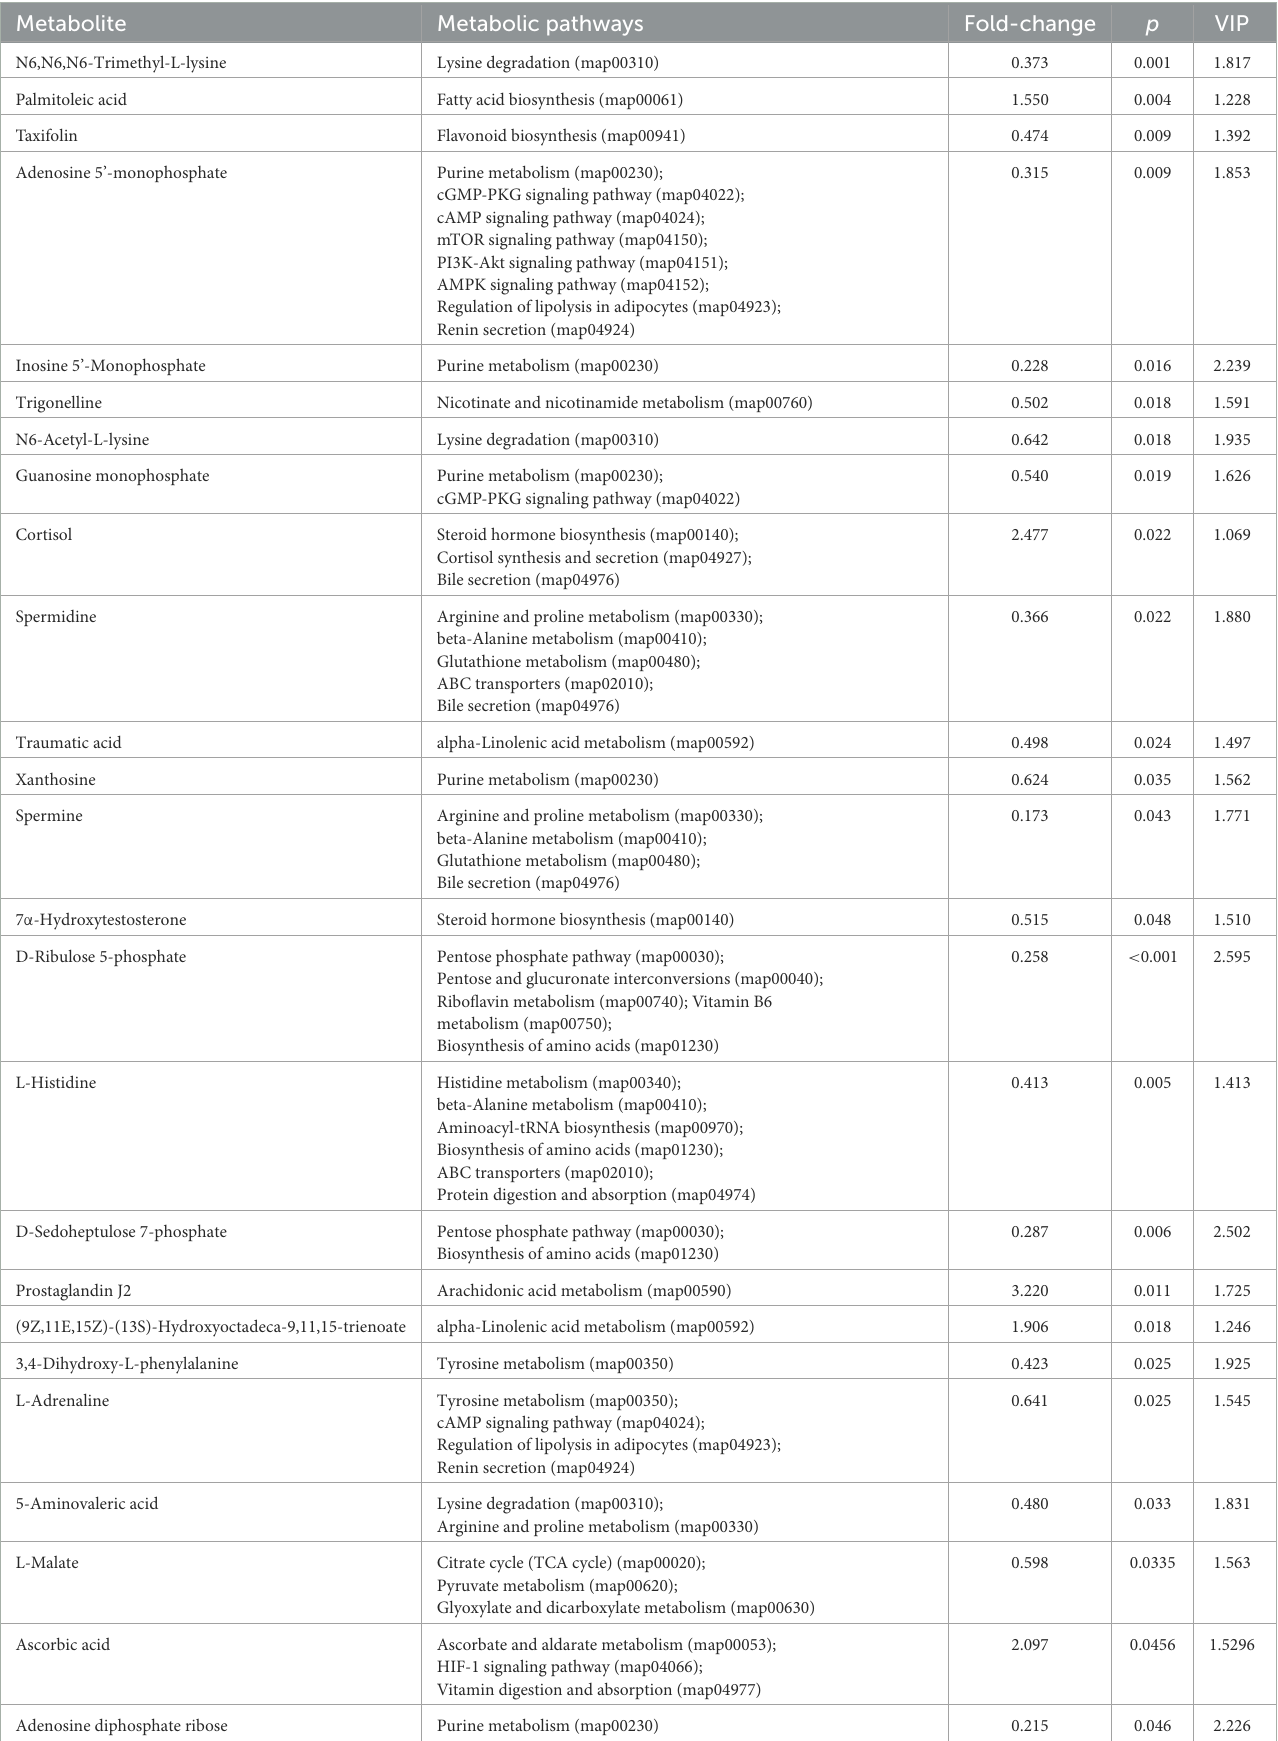
TABLE 8 Metabolites and their corresponding metabolic pathways